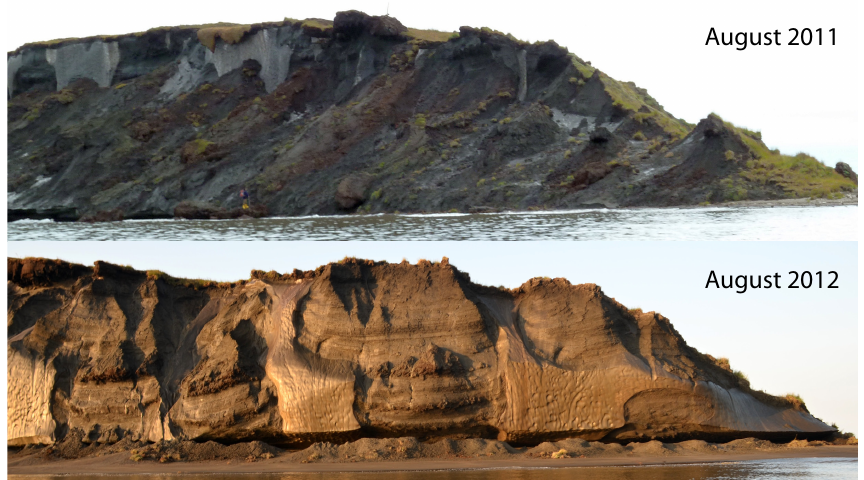
Figure 3. Appearance of the 21m high east coast close to the northern cape at the same season in 2 consecutive years. Top photograph: mud flows covering coastal bluff in 2011 indicates thermo-denudation (TD) surpassing thermo-abrasion (TA). Bottom photograph: nearly vertical ice-wall undercut by thermo-erosional niches in 2012 indicates TA surpassing